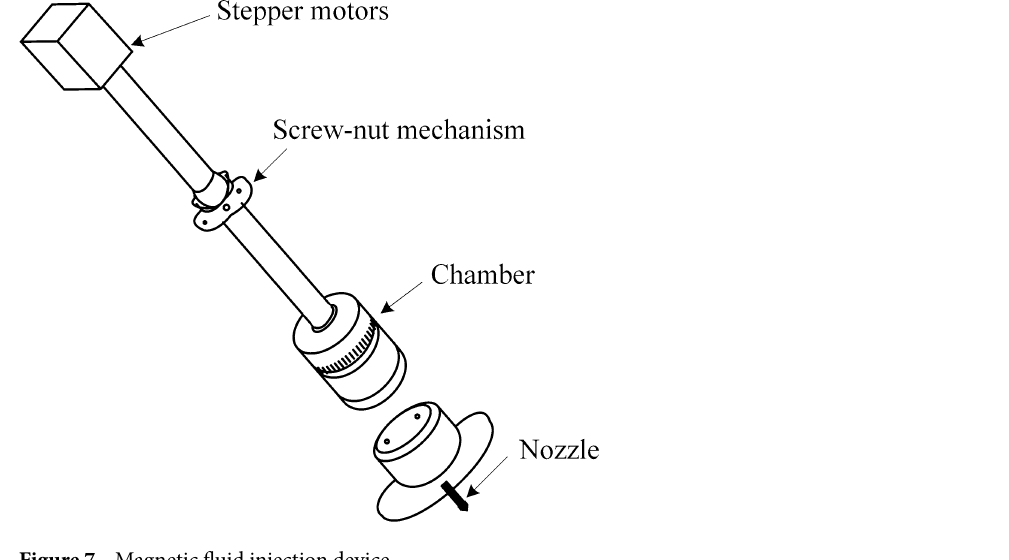
Figure 7. Magnetic fluid injection